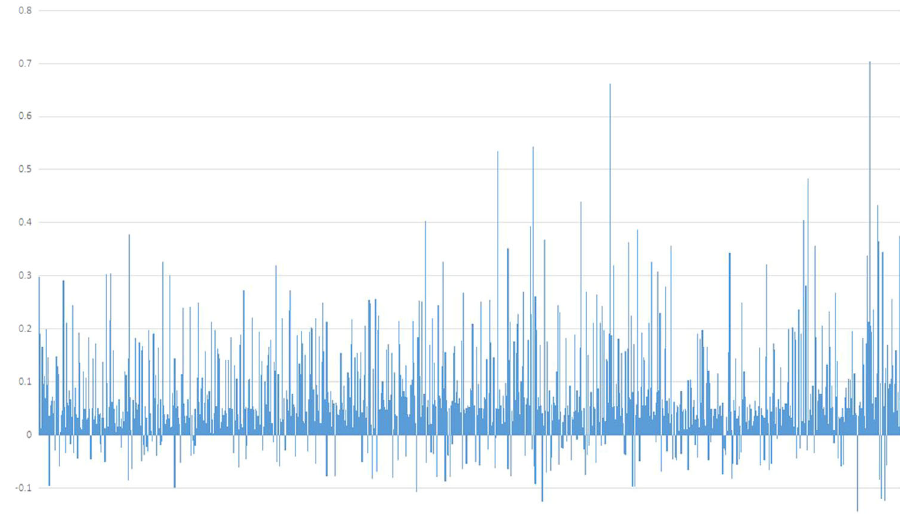
Fig. 1 Dynamic correlation. The dynamic correlation between internet postings and market dispersion.